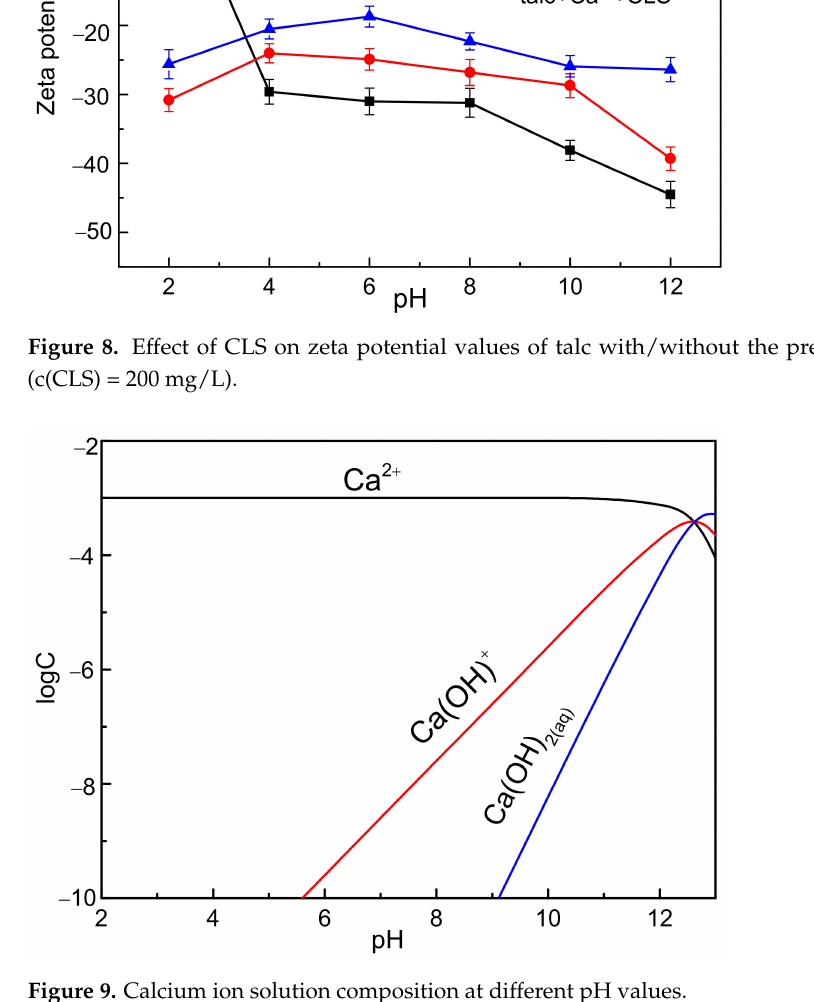
Figure 9. Calcium ion solution composition at different pH